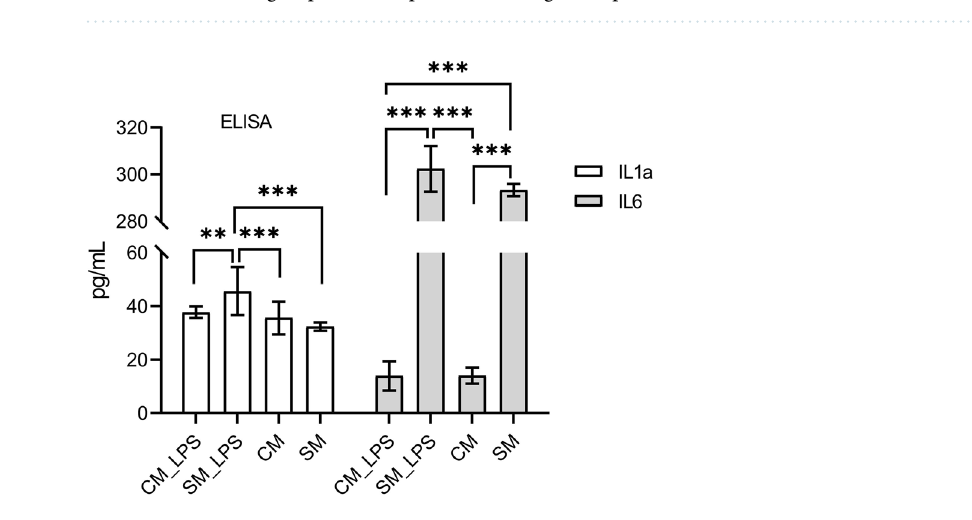
Figure 5. The mRNA levels of inflammation associated genes coding: IL-1α, IL-1β , IL-2 , IL-6 , IL-10 , IFNγ . The bars represent the (Me) with the 25th and 75th quartiles and the minimum and maximum of the copy numbers per 1 µg of total RNA. The Kruskal Wallis test with post hoc analysis was applied to assess any differences between groups in the expression of the genes, *p < 0.05.